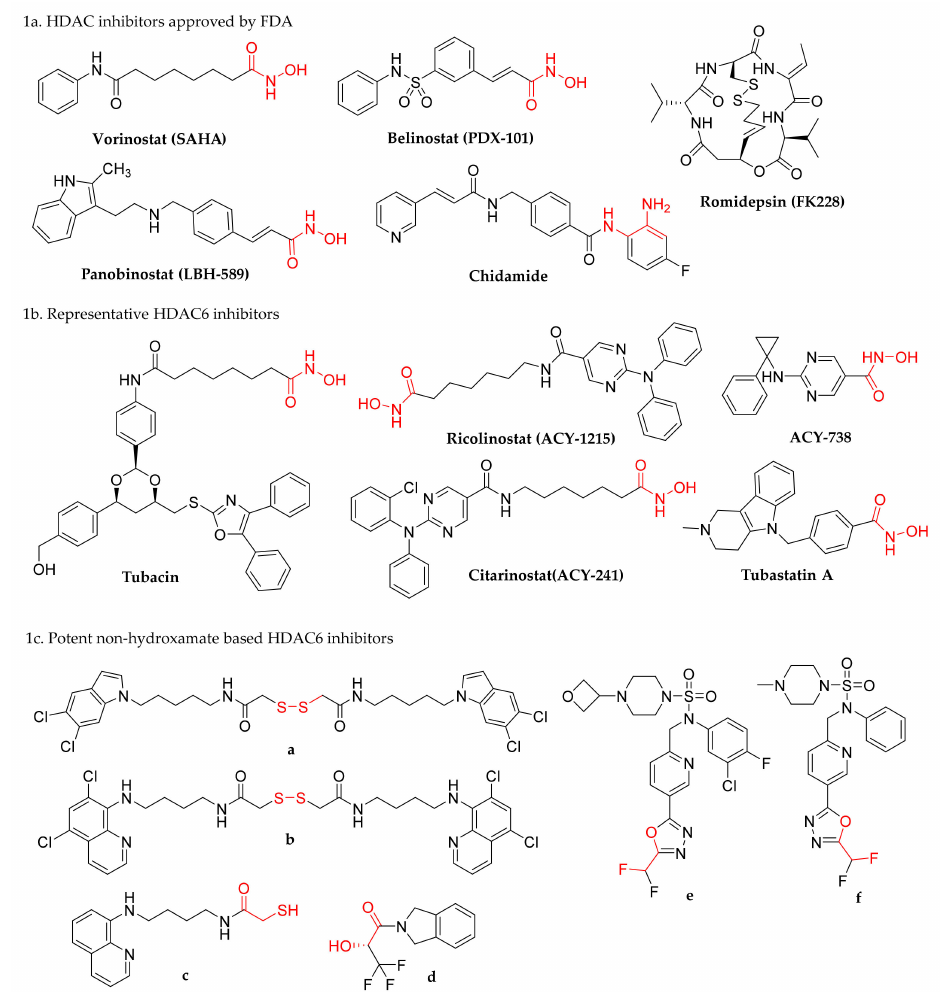
Figure 1. HDAC inhibitors approved by the FDA, representative HDAC6 inhibitors, and potent non-hydroxamate-based HDAC6 inhibitors. HDAC inhibitors approved by FDA ( 1a ); Representative HDAC6 inhibitors ( 1b ); Potent non-hydroxamate based HDAC6 inhibitors ( 1c ). To date, eighteen HDAC isozymes have been identified and classified in mammals, based on sequence homology to yeast protein orthologues, into four classes: class I